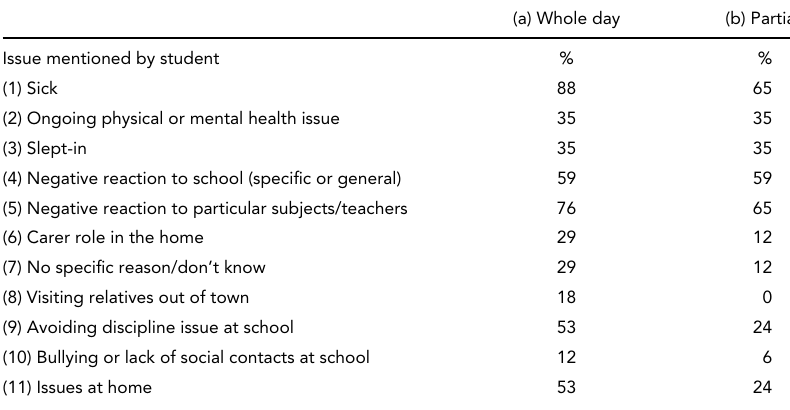
Reasons for Absences as Provided by Senior Students ∗ — One Urban